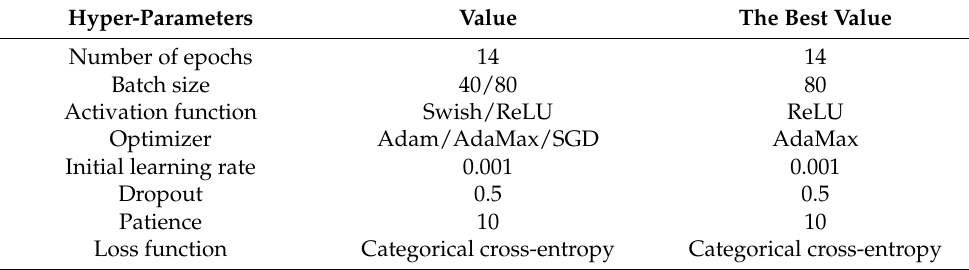
Table 2. Values of the hyper-parameters used in the Resnet101 model architectures. Hyper-Parameters